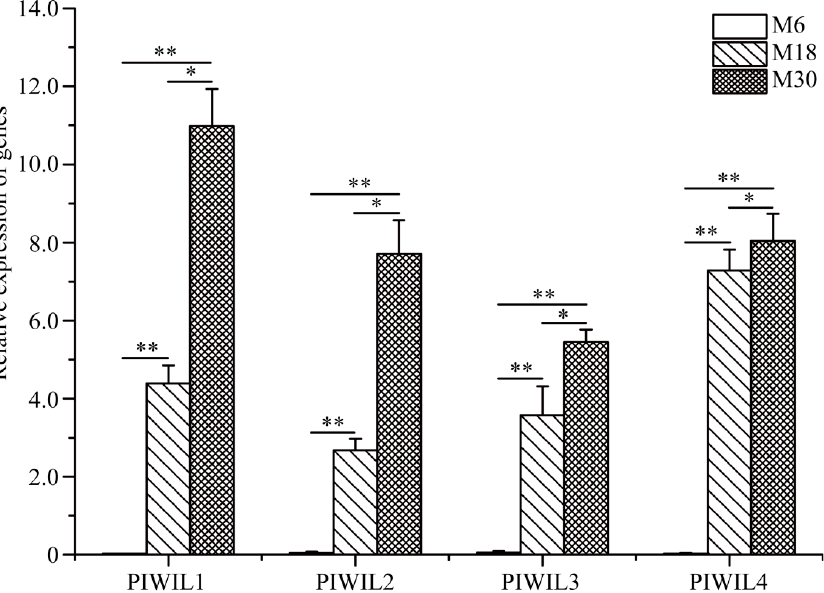
Figure 5. Relative mRNA expression of PIWIL family proteins was measured by qRT-PCR in 6-, 18-, and 30-month-old yak testes. * p < 0.05, ** p < 0.01.